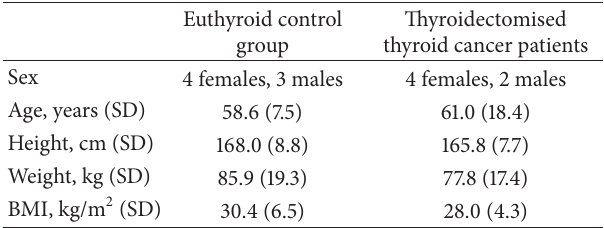
Table 1: Group demographics of control and thyroidectomised